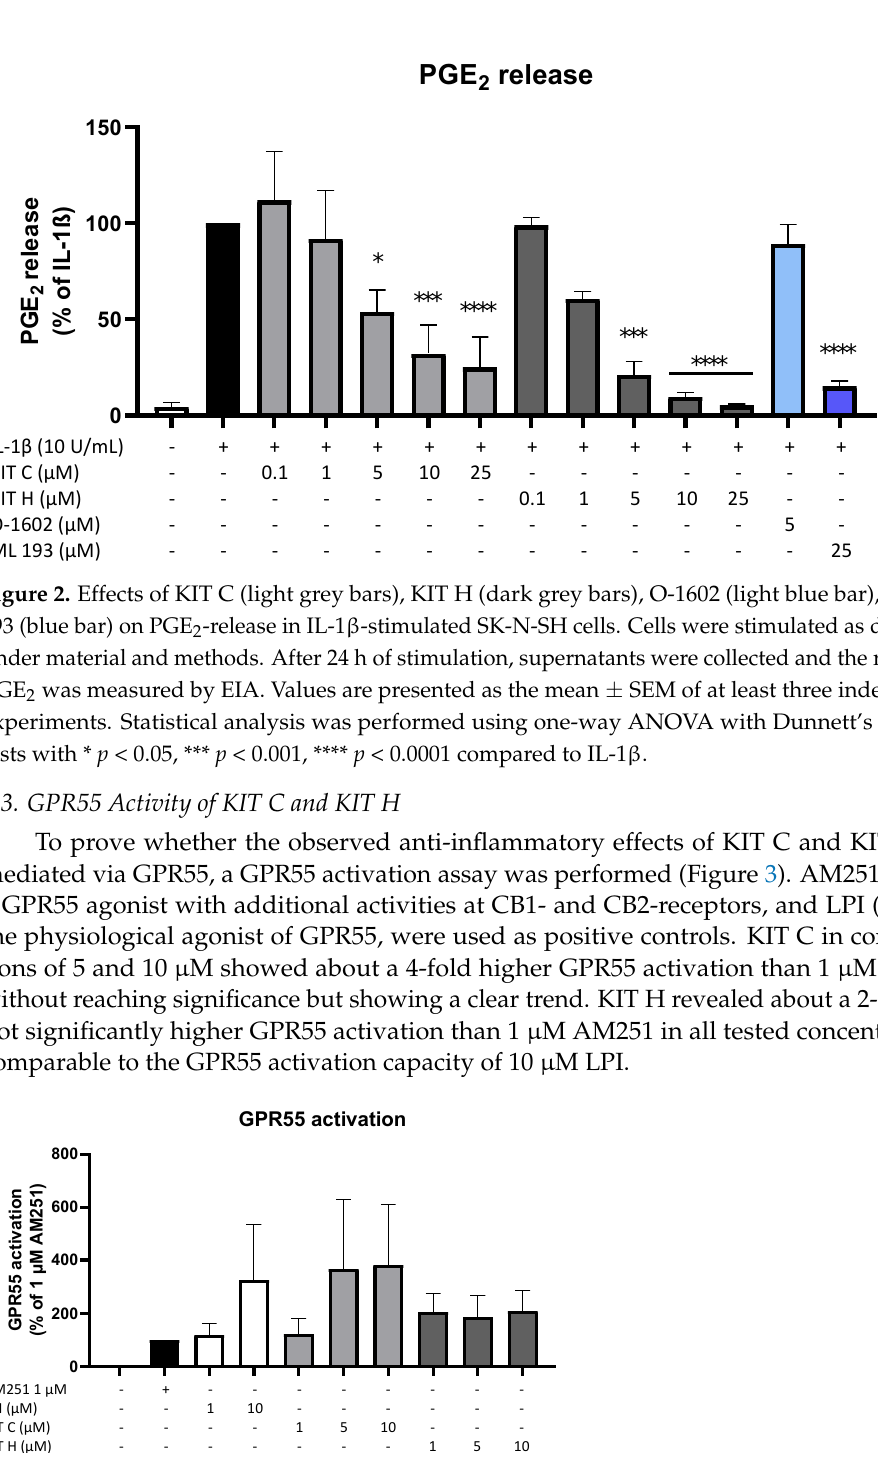
Figure 3. GPR55 activation by AM251 (black bar), LPI (white bars), KIT C (light grey bars), and KIT H (dark grey bars) in HEK293T-GPR55 cells. Cells were treated as described under material and methods. After 6 h of stimulation, cells were lysed, and the luciferase activity was measured. Values are presented as the mean ± SEM of at least three independent experiments. Statistical analysis was performed using one- way ANOVA with Dunnett’s post hoc tests compared to 1 µM AM251.